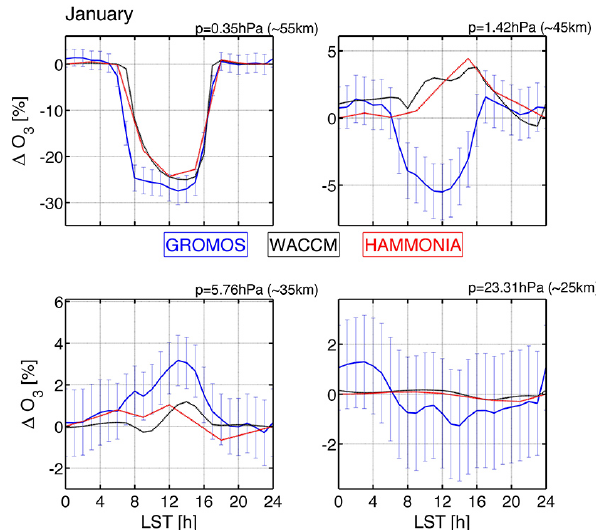
Figure 6a. Relative mean differences for four different pressure lev- els in January. GROMOS is given by the blue line, while WACCM is given in black and HAMMONIA in red. The error bars denote the mean standard deviation of